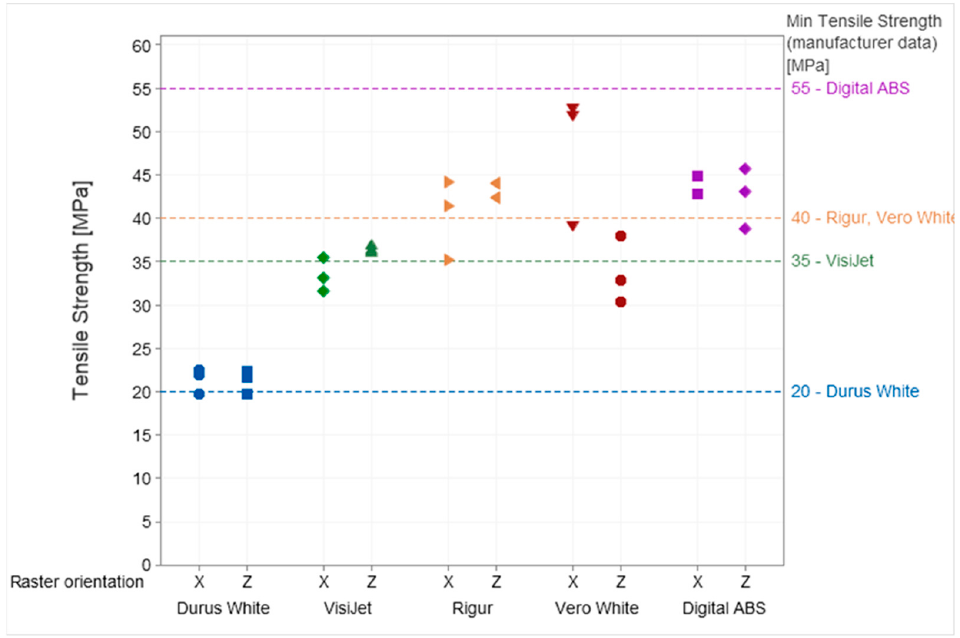
Figure 6. Results of tensile strength obtained during the test for Durus, VisiJet, Rigur, Vero, and ABS materials.